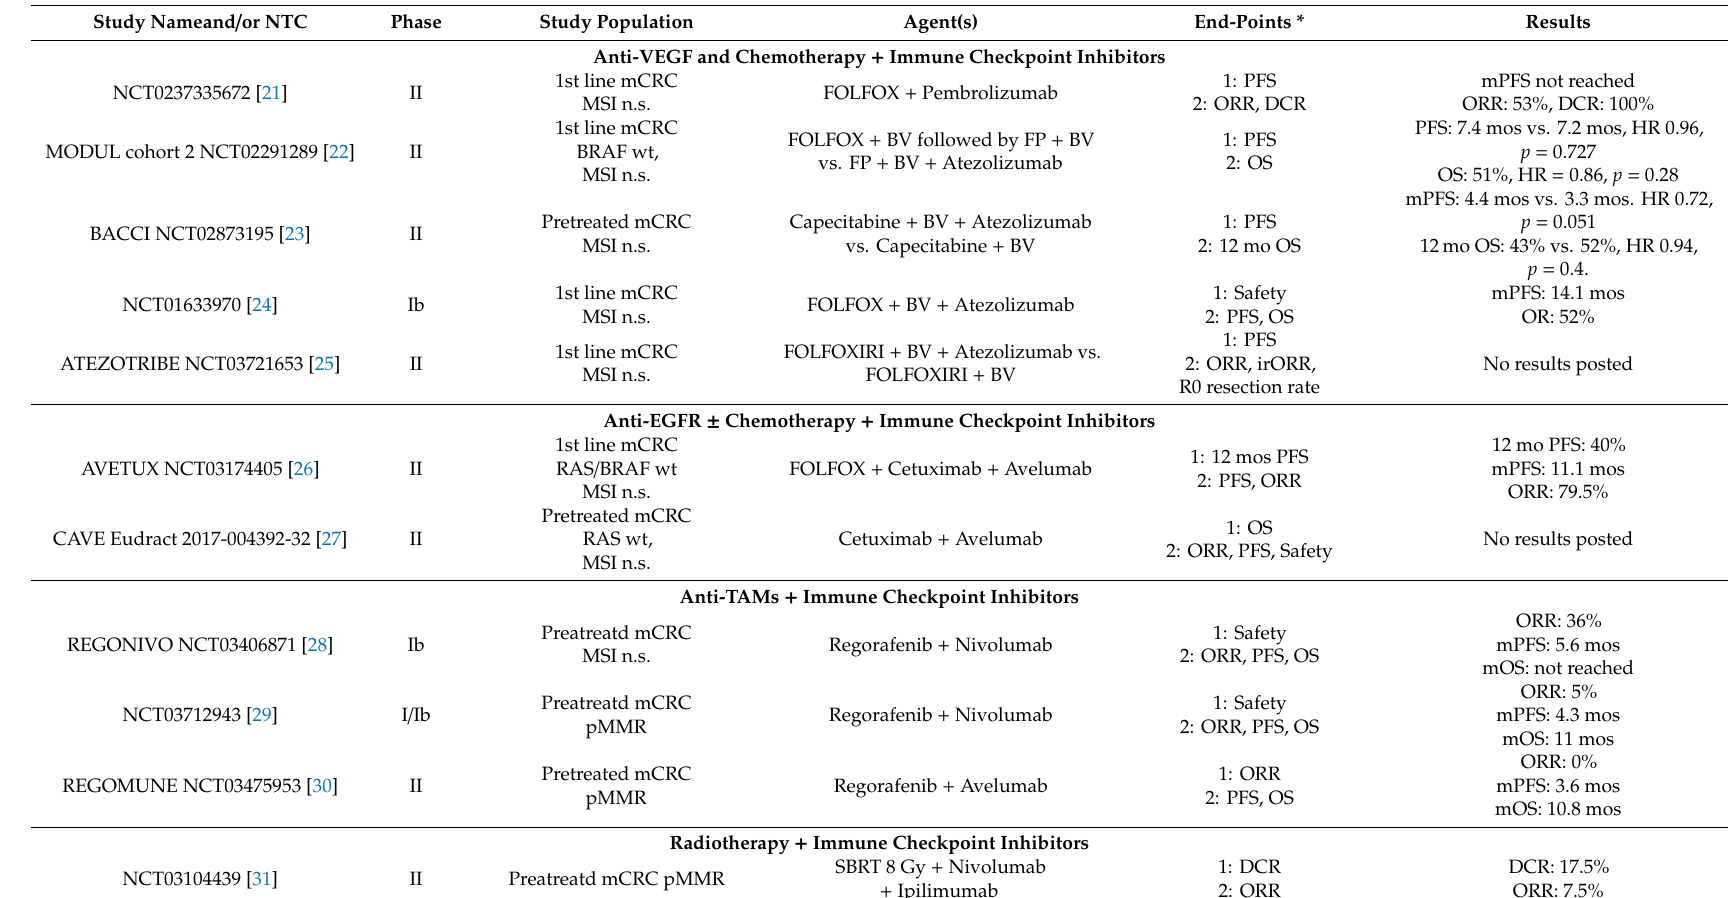
Table 1. Selection of completed trials investigating the use of immune checkpoint inhibitors for proficient mismatch repair (pMMR) or non-specified microsatellite status (MSI n.s.) colorectal